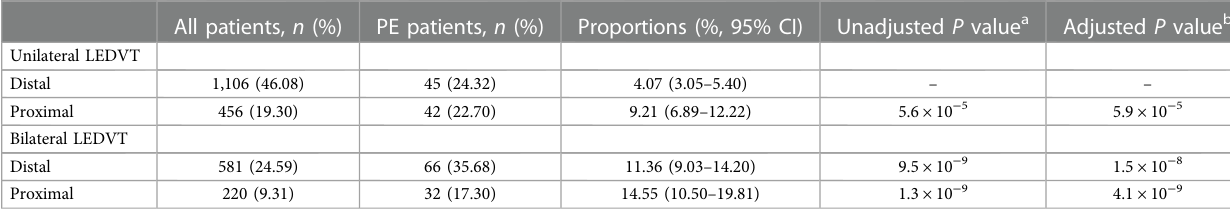
TABLE 2 Proportions of pulmonary embolism strati fi ed by the anatomic distribution of lower extremity deep venous